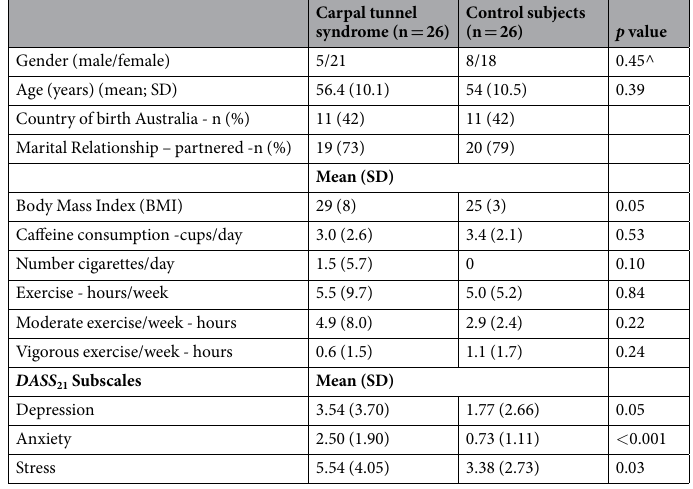
Table 1. Demographic and clinical data. SD = standard deviation; DASS21 = Depression, Anxiety, Stress scale 21 item; ^Chi-square